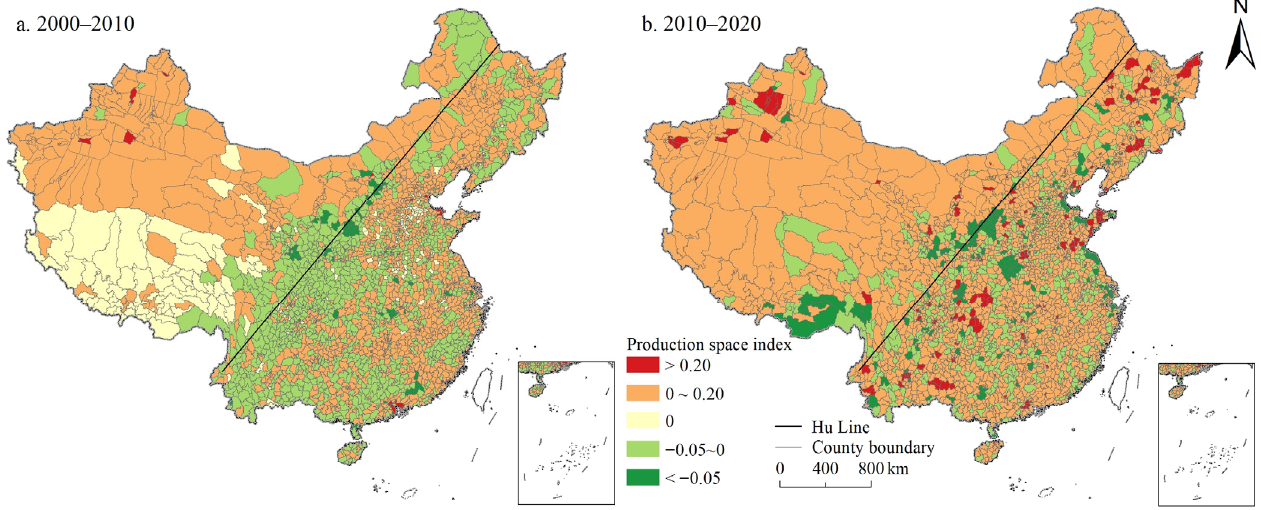
Int. J. Environ. Res. Public Health 2022 , 19 , 10370 Figure 1. Spatial distribution of PSI changes in China during 2000–2020. Figure 1. Spatial distribution of PSI changes in China during 2000–2020.